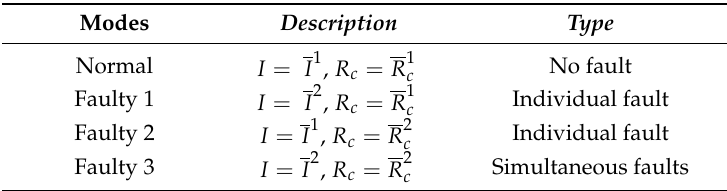
Table 2. Faults definition and